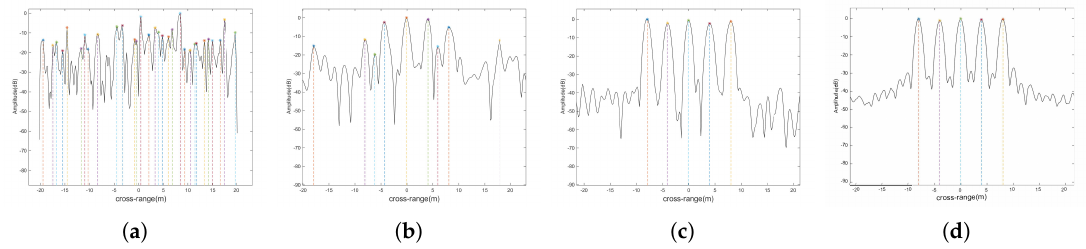
Figure 9. The profile of one range bin in ( a – c ) Three corrected subimages; ( d ) the fusion image .